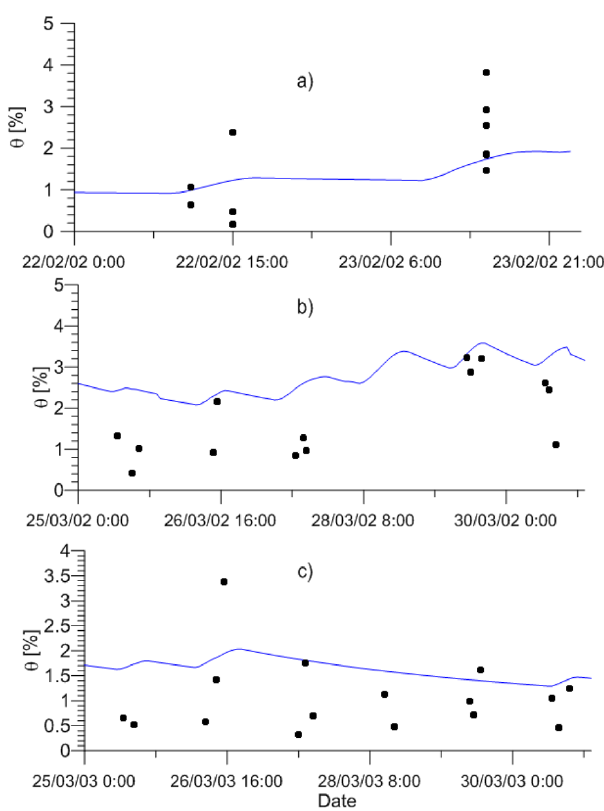
Fig. 6. Comparison between simulated θ at S3 during three simula- tion periods in 2002 and 2003 (blue line) and manually measured values of θ at LSOS site, NASA CLPX field experiment (black